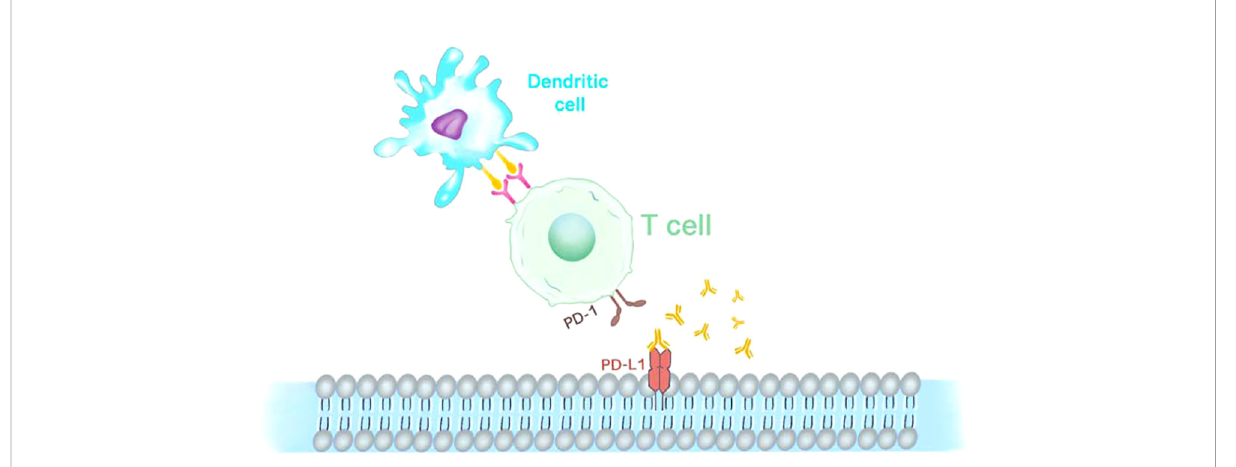
FIGURE 2 Immunotherapy anti PD-1 and PD-L1. PD-1 is expressed on the surface of CAR-T cells as an inhibitory receptor, while its ligands PD-L1 is mainly expressed in antigen-presenting cells and tumor